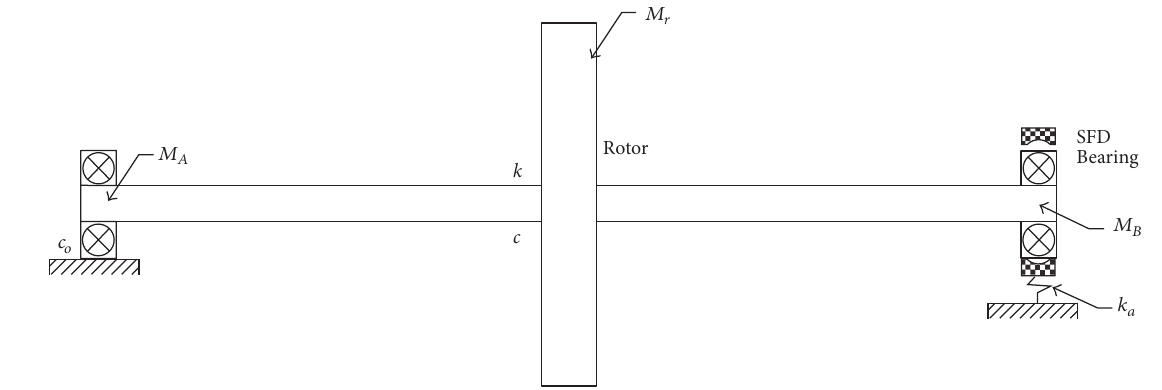
Figure 4: The model of the rotor-bearing-SFD